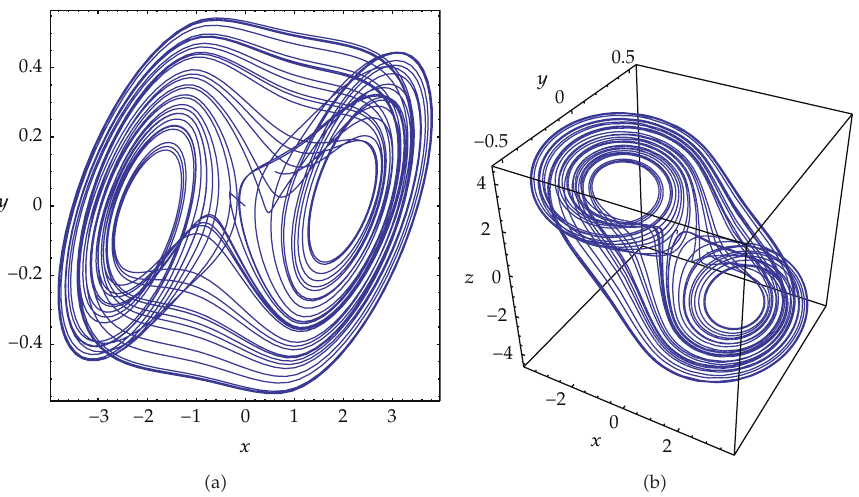
Figure 1: Phase plot of Chua’s chaotic attractor with q 1 (cid:7) q 2 (cid:7) q 3 (cid:7) 1, α (cid:7) 9 . 085: (cid:3) a (cid:4) in the x - y space, (cid:3) b (cid:4) in the x - y - z space.